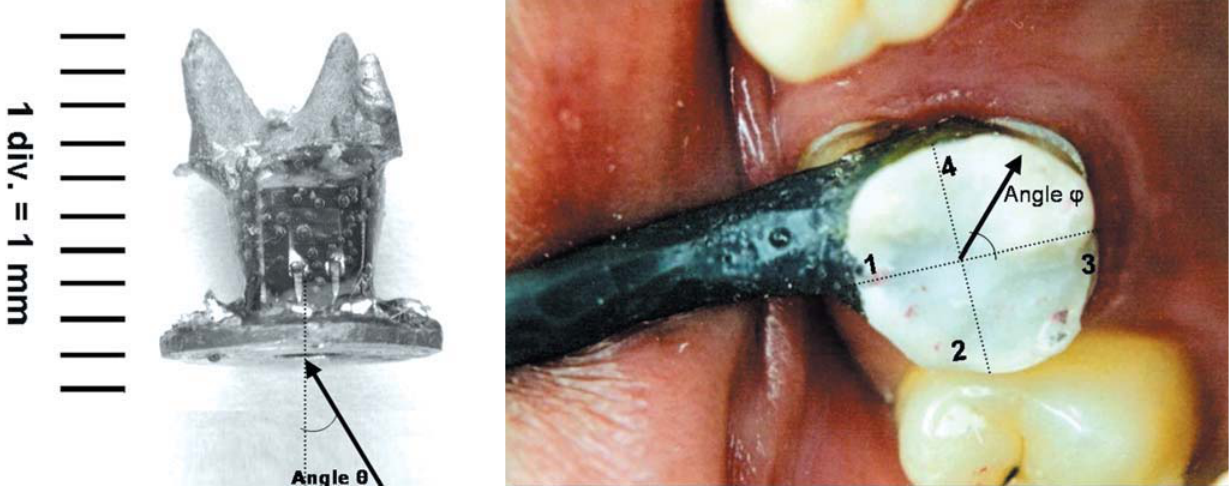
FIGURE 1- Left: Detail of load cell without the crown’s mold and angle of vertical inclination θ . Right: Load cell implanted in the patient and angle ϕ of the tangential component in the occlusal plane